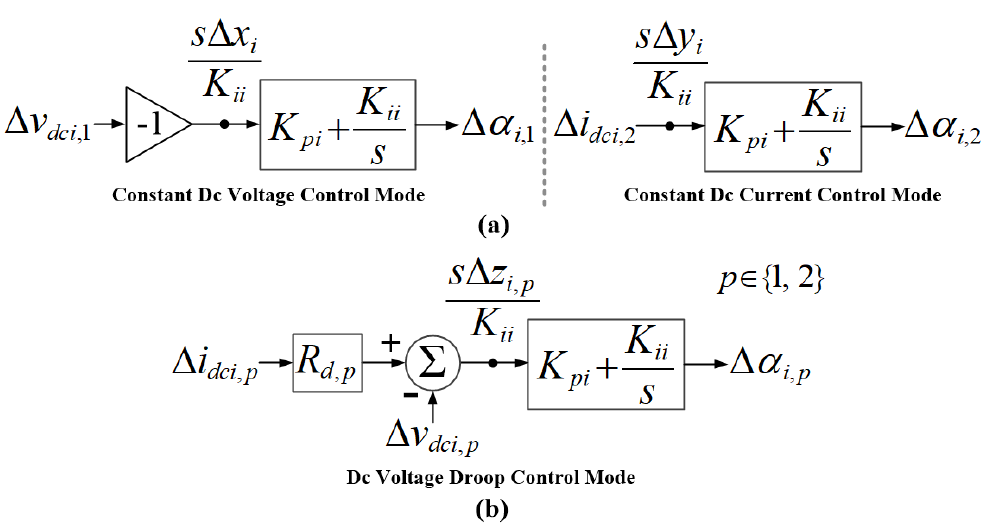
Figure 4. A control scheme of grid side LCCs in ( a ) master–slave control mode and ( b ) voltage droop control